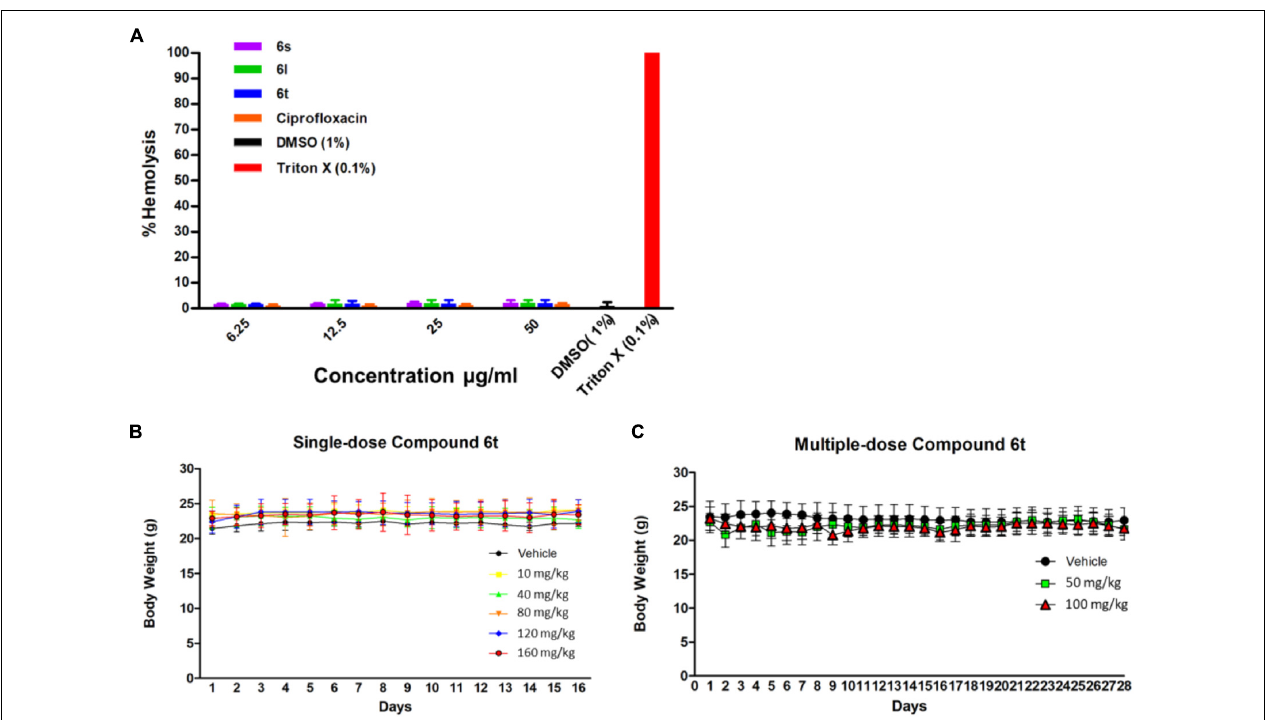
FIGURE 6 | Toxicity assays. (A) Hemolysis assay for compounds and the control antibiotic ciprofloxacin at concentrations of 6.25–50 µ g/ml. Triton × 100 (0.1%) was used as a positive control to produce complete hemolysis. (B) Effect of single-dose compound 6t on mice weight over time. Mice were treated with indicated dose of 6t vehicle (0.5% DMSO in PBS) and weight was monitor for 14 days ( n = 3). (C) Effect of multiple-dose of compound 6t on mice weight over time. Mice were treated with compound 6t at concentration of 50 and 100 mg/kg/day or vehicle (0.5% DMSO in PBS) for 14 days and body weight was observed for an additional 14 days ( n =